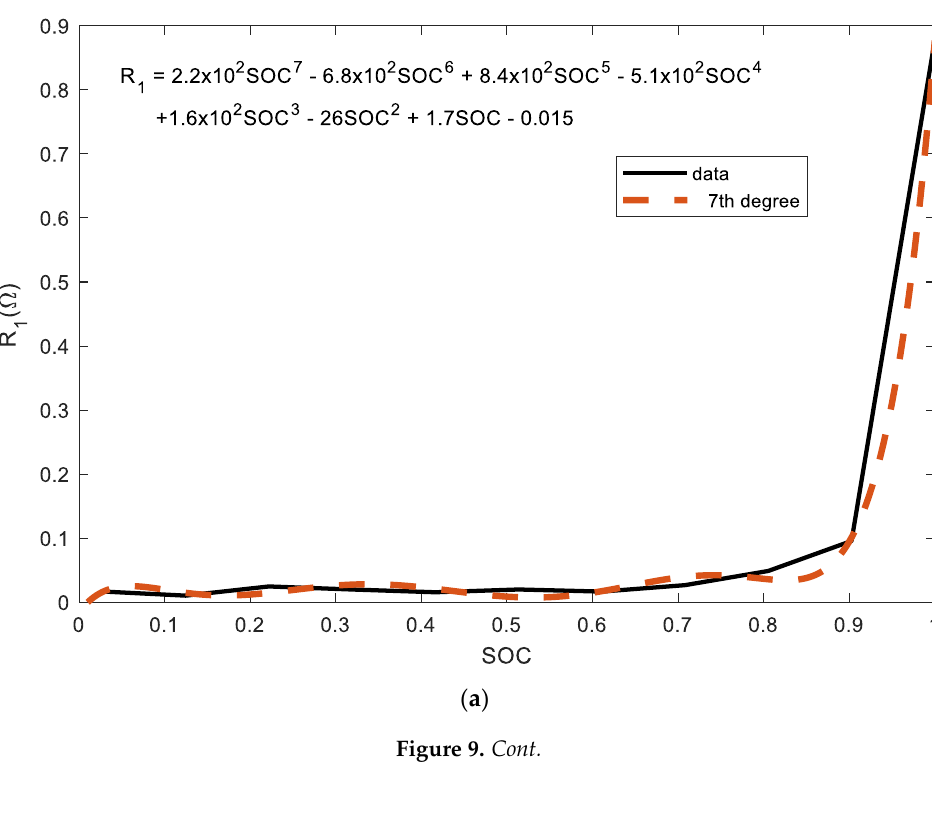
Figure 8. R 0 as function of ( a ) SOC ; ( b ) SOC and ambient temperature.